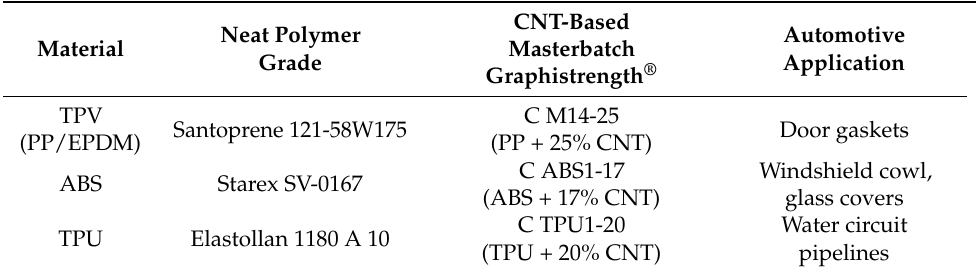
Automotive Application